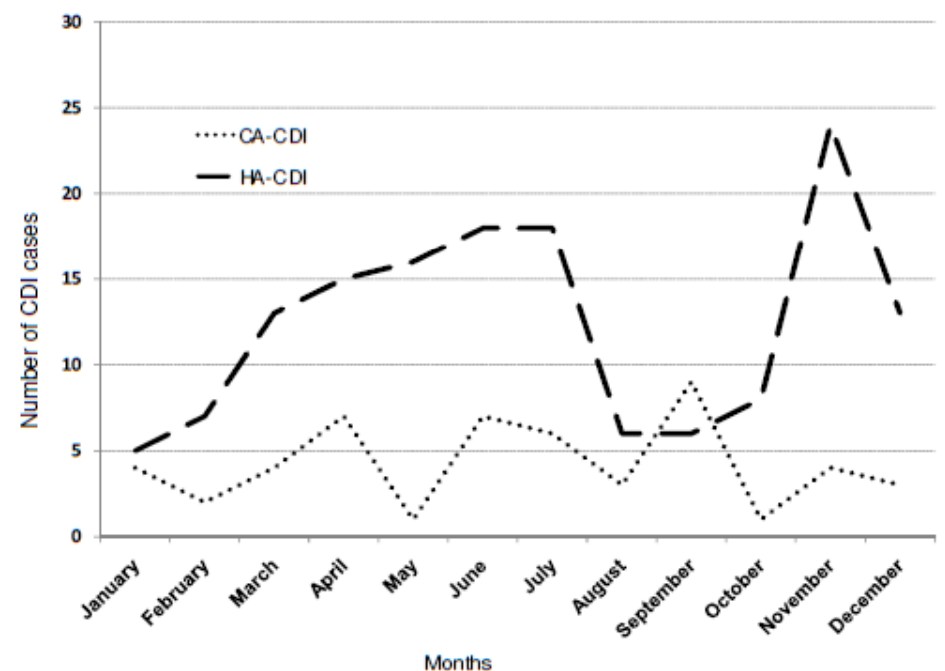
Figure 1. The occurrence of community-acquired CDI (CA-CDI defined by the ECDC) and the hospital-acquired CDI (HA-CDI, defined by the ECDC) in 2012–2018, at St. Luke Hospital in Tarn ó w,